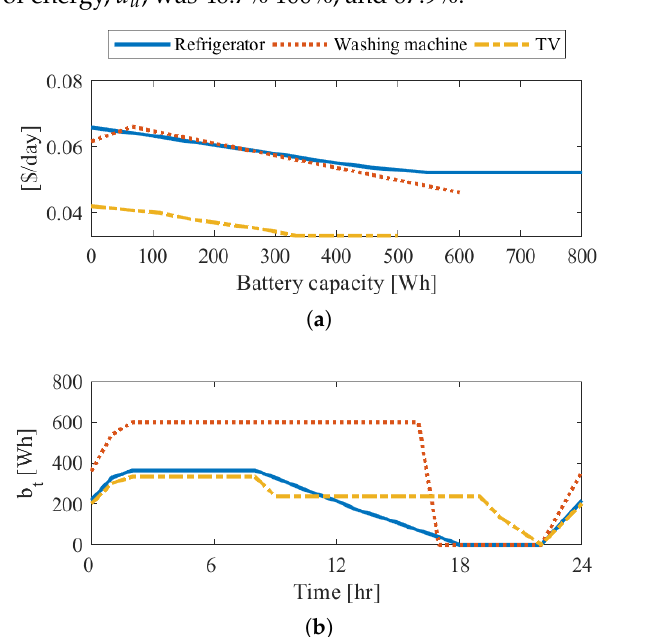
Figure 5. Optimal battery capacity analysis results of Case 2, δ 1 = 0.9, δ 2 = 0.9. ( a ) Home